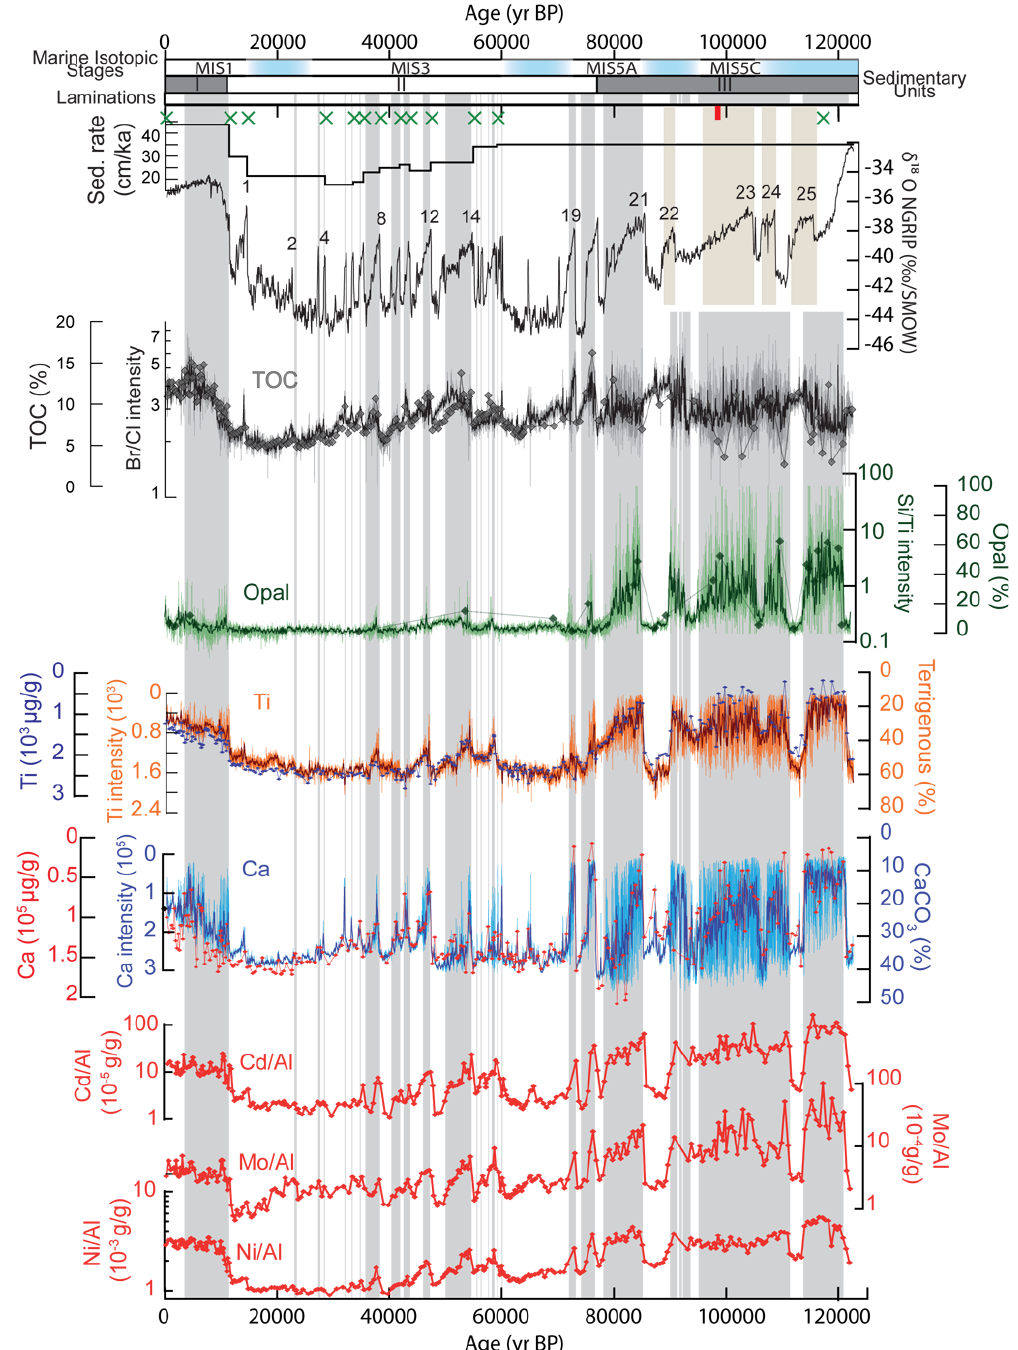
Fig. 2. The sedimentation rate in MD08 core; the isotopic composition of NGRIP ice core ( δ 18 O‰/SMOW) (NGRIP Members, 2004); the Br/Cl based marine organic matter high resolution record for MD02-2508 core calibrated using TOC measurements on the same core (the TOC data were first reported by Blanchet et al. (2007), and 40 additional TOC measurements were added from 120 to 60ka). Si/Ti record calibrated using opal measurements (green diamonds). Ca measurements (XRF scan and ICP-MS), converted into carbonate content considering that all the Ca belongs to the carbonate phase. Ti XRF and ICP-MS records converted into terrigenous matter content calculated using mean Ti content in the upper continental crust (McLennan, 2001). Note that Ca and Ti scales are reversed. Cd/Al, Mo/Al, and Ni/Al measured using ICP-MS on log scale. Green crosses at the top of the figure indicate tie points used to build the age model. Marine isotopic stages and sedimentary units as described in part 3 are indicated. Grey vertical bars highlight the laminated layers. Red tick at the top of the figure indicates the position of the sample displayed in Fig.